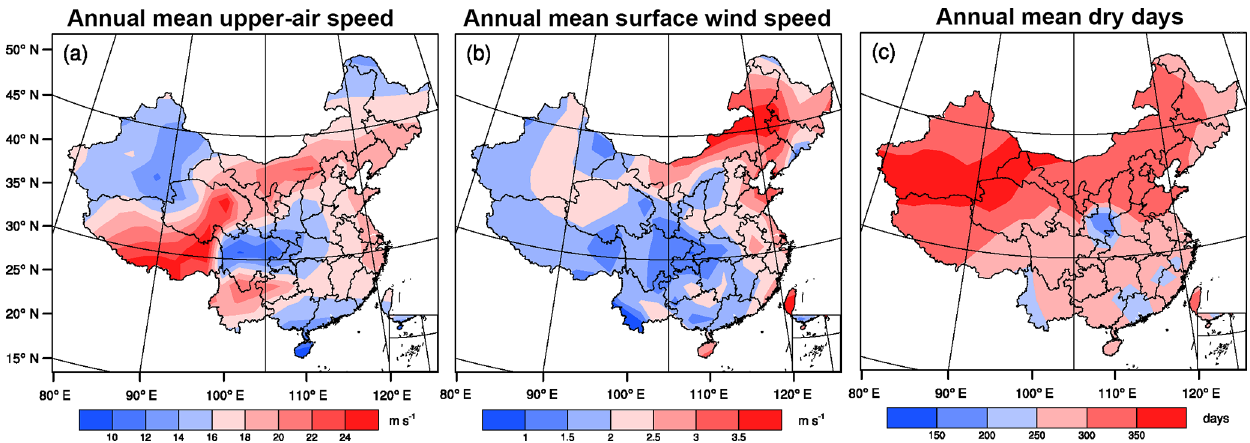
Figure 7. Annual mean upper-air wind speed (a) , surface wind speed (b) , and dry days (c) in China (1985–2014).